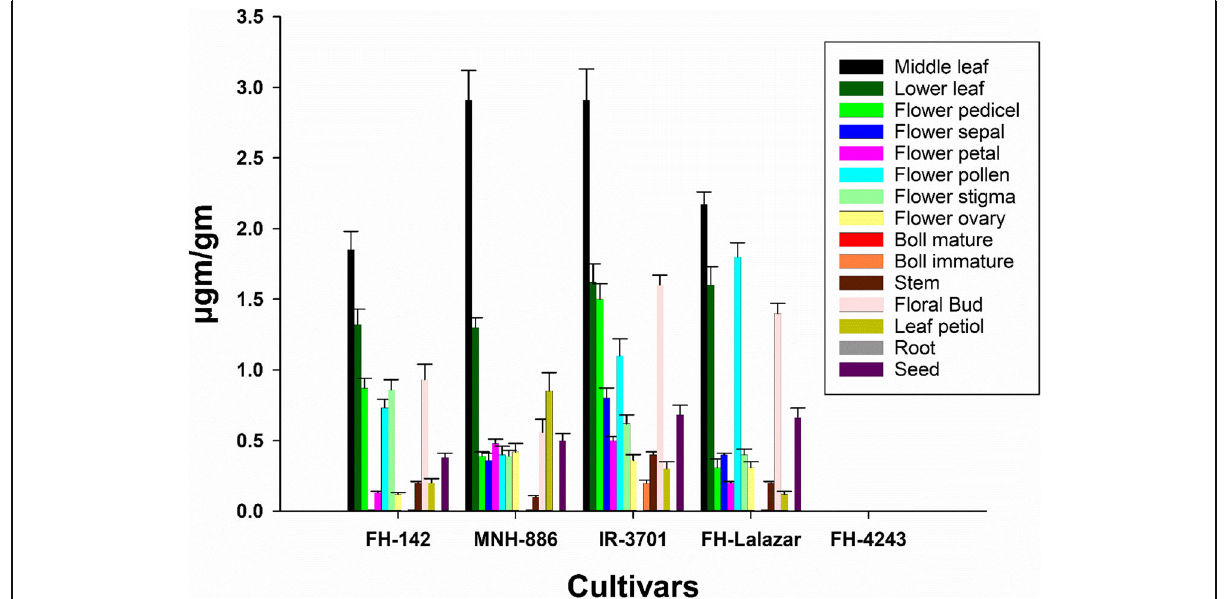
Fig. 1 Bacillus thuringiensis expression of Cry1Ac ( μ g/g of fresh wt.) in different parts of the